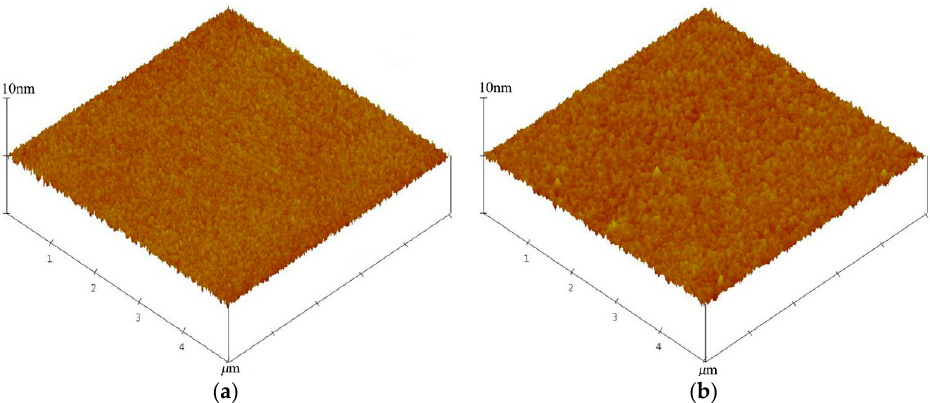
Figure 3. Three-dimensional (3D) atomic force microscopy (AFM) images of wafer surfaces. ( a ) Root mean square (RMS) of as-received wafer is 0.199 nm; ( b ) RMS after etching for cavity is 0.293 nm.